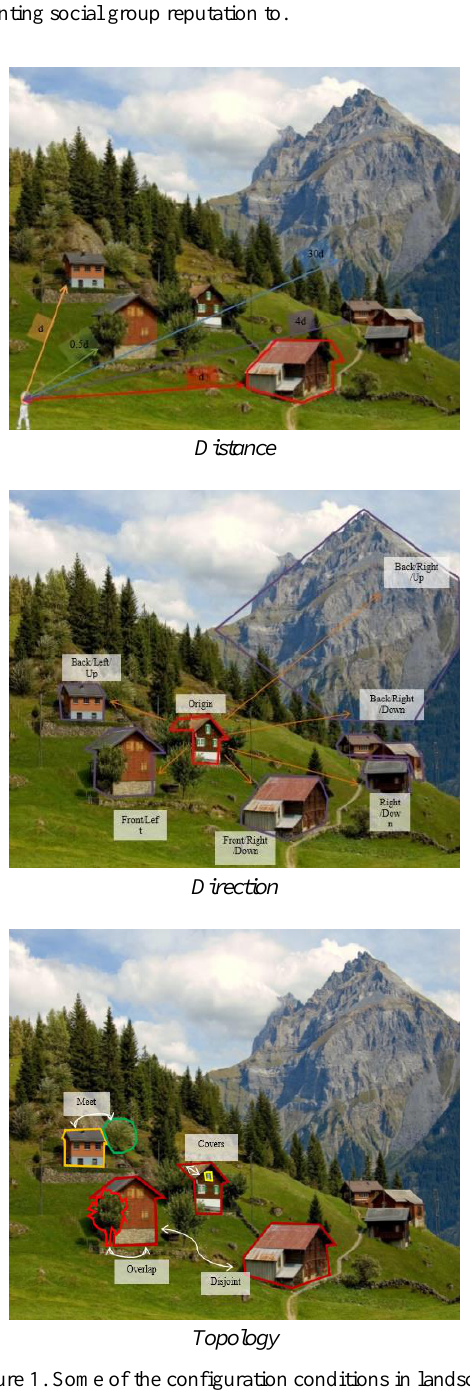
Figure 1. Some of the configuration conditions in landscape